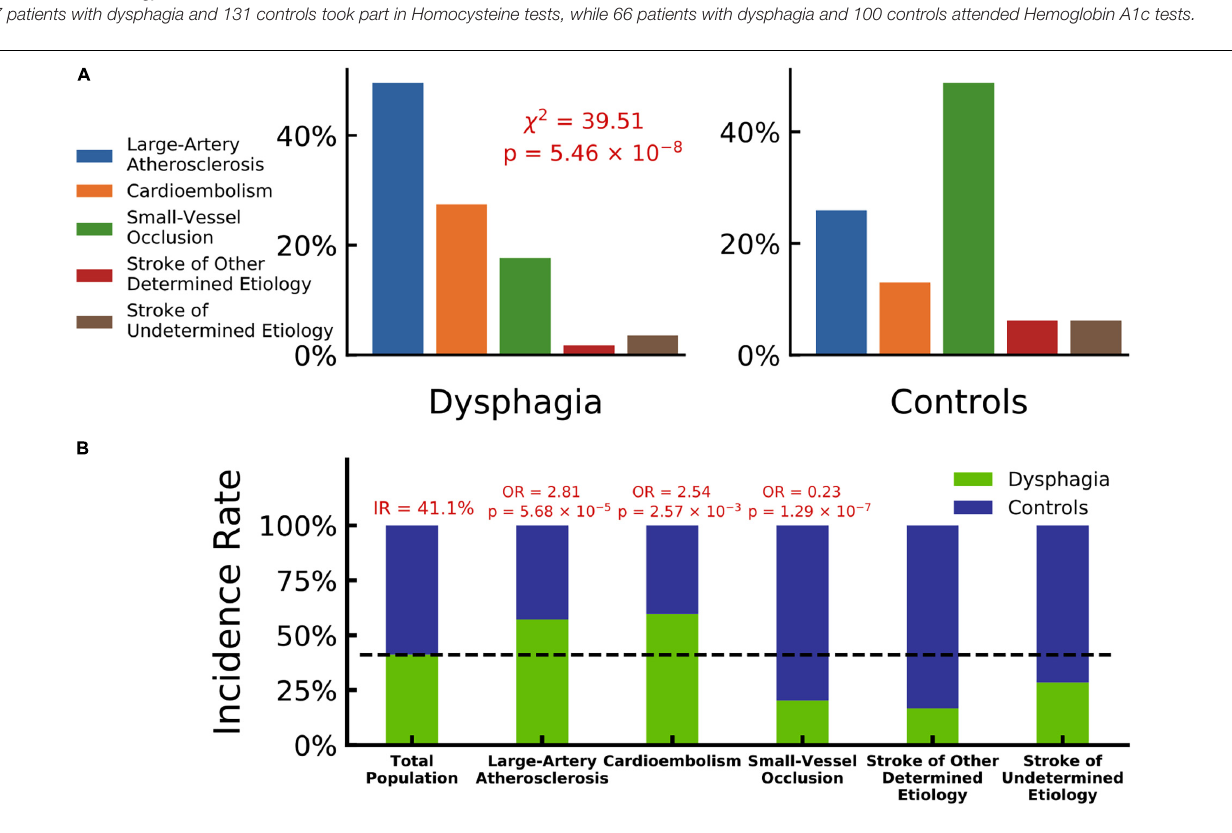
FIGURE 1 | Dysphagia and stroke associations by TOAST classification. (A) Composition ratios of TOAST classification (blue: large-artery atherosclerosis, orange: cardioembolism, green: small-vessel occlusion, violet: stroke of other determined etiology and red: stroke of undetermined etiology) in patients with dysphagia and controls, which indicates a significantly strong association between dysphagia and stroke by TOAST classifications (Chi-squared test, χ 2 = 39.51, p = 5.46 × 10 − 8 ). (B) Incidence rate of dysphagia in different TOAST classifications (patients with dysphagia in green and controls in blue). The incidence rate of total population is 41.1%. Large-artery atherosclerosis and cardioembolism hold odd ratios significantly larger than 1 with dysphagia (OR = 2.81, p = 5.68 × 10 − 5 and OR = 2.54, p = 2.57 × 10 − 3 ), while small-vessel occlusion holds an odd ratio significantly lower than 1 (OR = 0.23, p = 1.29 × 10 − 7 ).